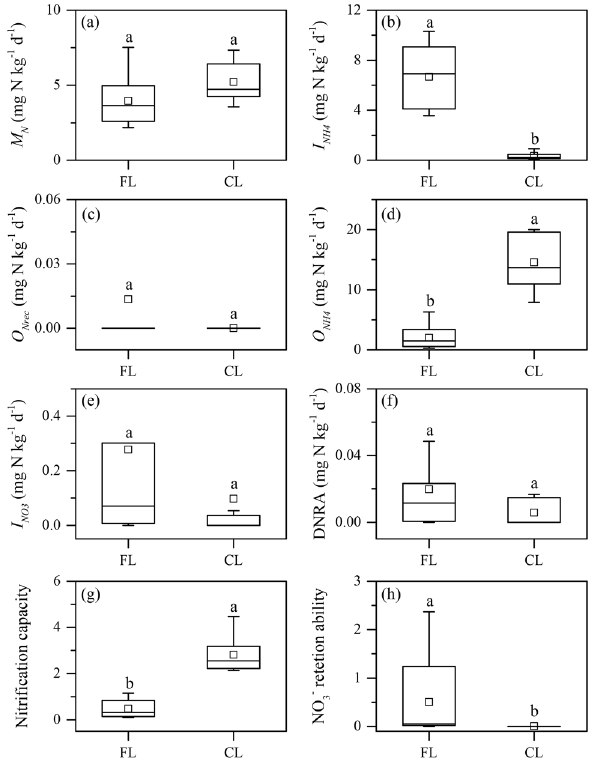
Figure 3. Gross N transformation rates in the forestland and cropland soils estimated using the 15 N tracing model. Abbreviations: M N total N mineralization ( a ); I NH4 total NH 4 + immobilization ( b ); O Nrec heterotrophic nitrification ( c ); O NH4 autotrophic nitrification ( d ); I NO3 NO 3 − immobilization ( e ); DNRA: dissimilatory NO 3 − reduction to NH 4 + ( f ); nitrification capacity: ratio of O NH4 to M N ( g ); NO 3 − retention capacity ratio of total NO ( P < 0.05). The bottom/top of the box denote 25th/75th percentiles. Whiskers denote 5th/95th percentiles. The squares denote the mean values, and the black lines denote the mid-values.